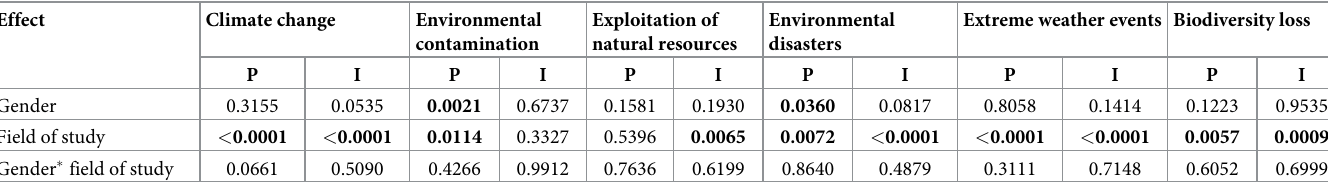
Table 3. Results of the two-way ANOVA for probability (P) and impact (I) of individual environmental risks with p < 0.05.